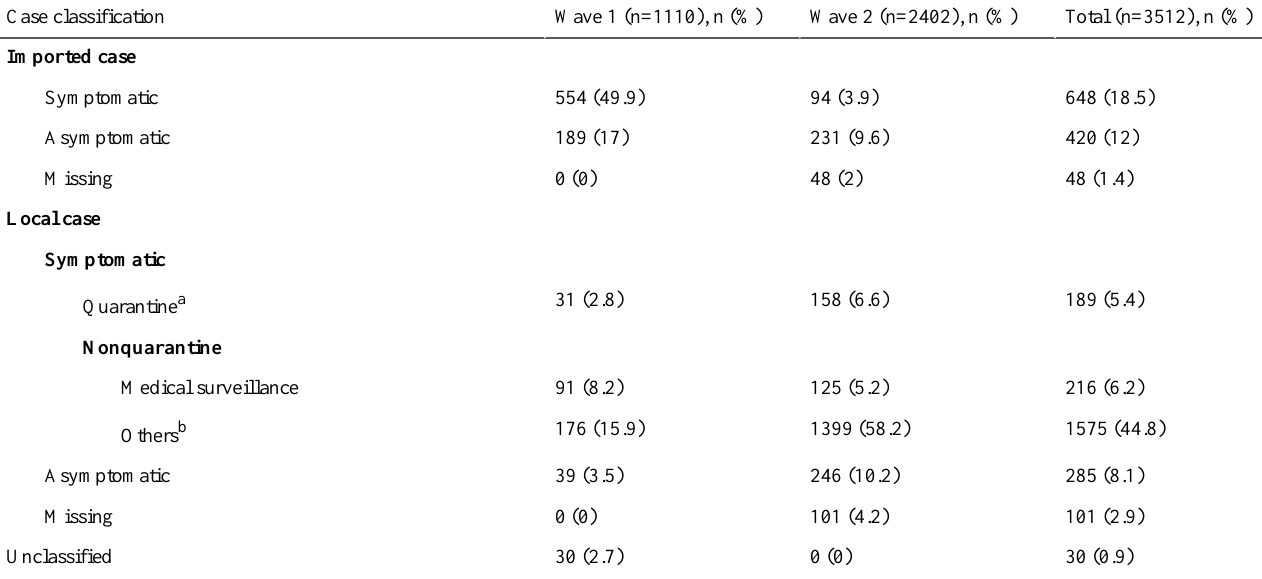
Table 2. Classification of 3512 cases in Hong Kong, as of August 2,